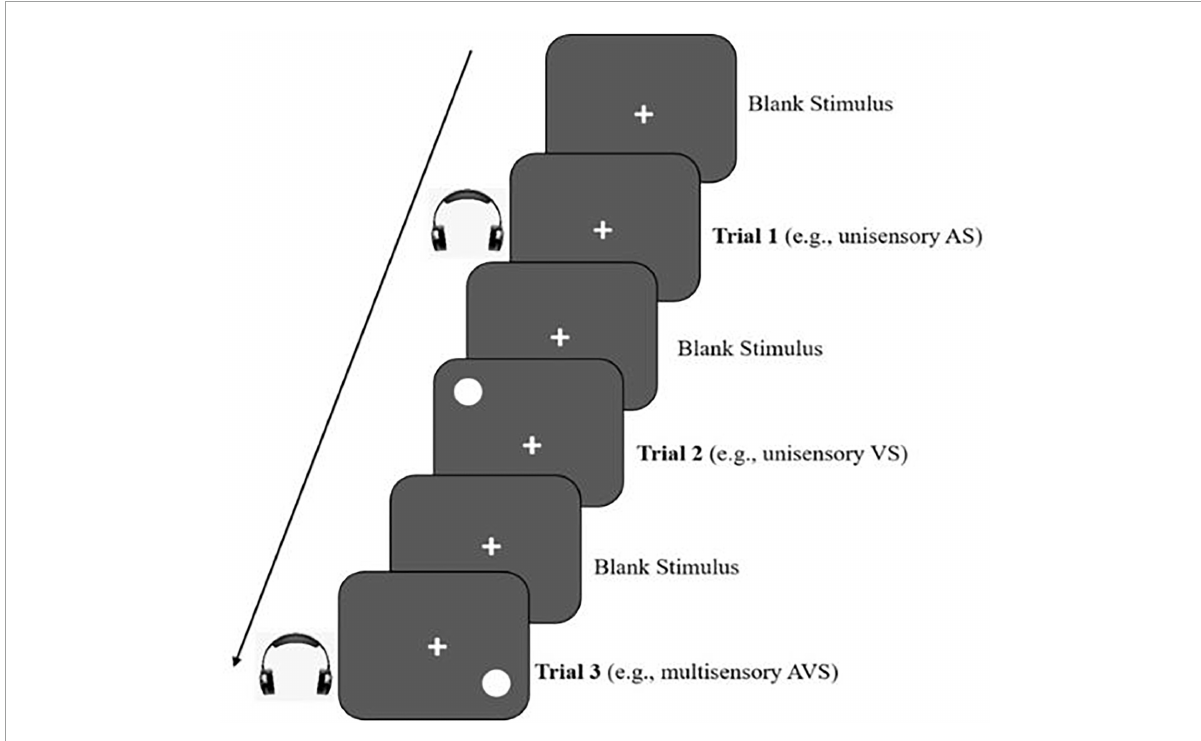
FIGURE2 An example of a sequence of multisensory task trial showing each of the stimuli type.